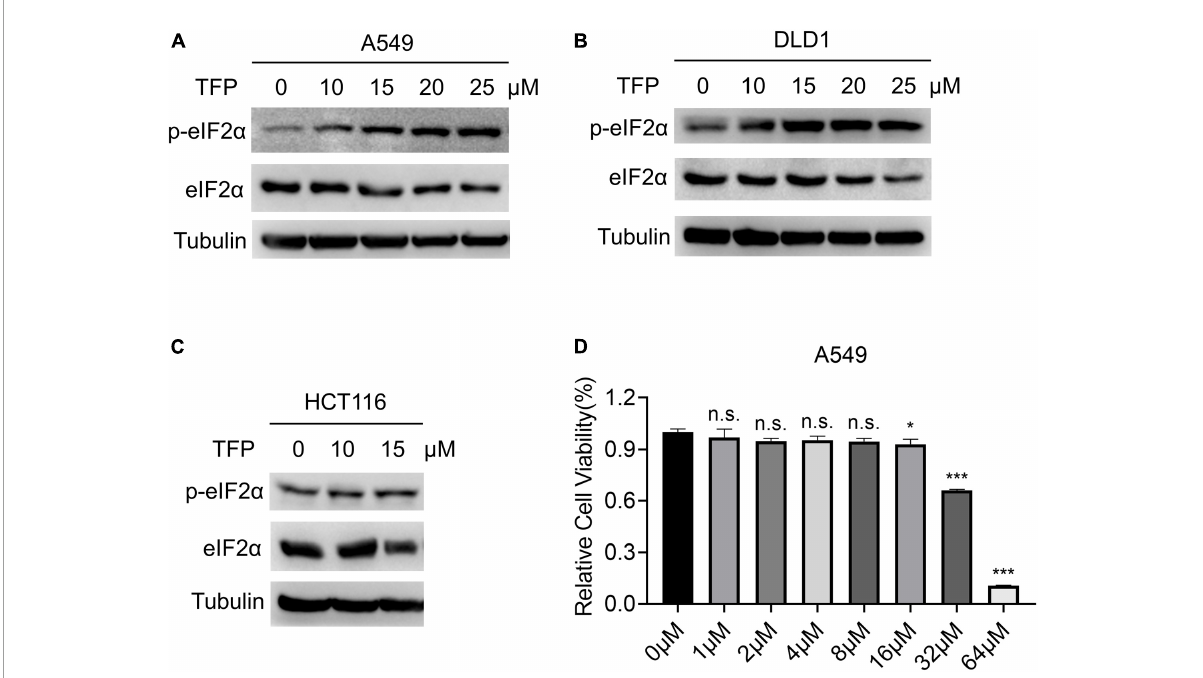
FIGURE1 TFP promotes the phosphorylation of eIF2 α . (A–C) A549, DLD1, and HCT116 cells were treated with TFP at different concentrations from low to high for 12 h. (D) A549 cells were treated with different concentrations of TFP for 36 h, and cell viability was detected by the Cell Counting Kit-8 (CCK-8) assay. Statistical analysis was performed by one-way ANOVA with Bonferroni’s post-test, comparing each group with the control group. * p < 0.05, *** p < 0.001, n.s., not significant.